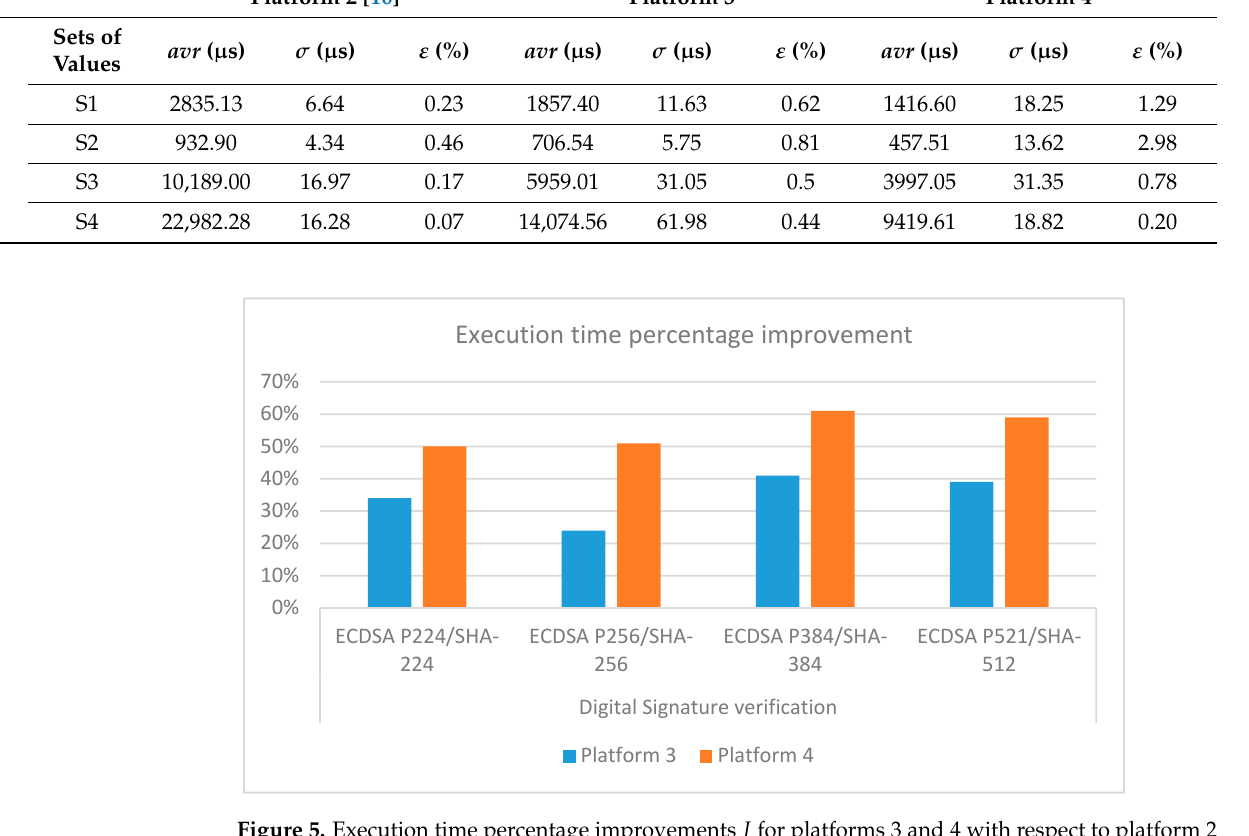
Table 7. Execution time profiling of the digital signature verification obtained on the three embedded platforms with the sets of values S1 to S4 in Table 3. © [2020] IEEE. Extended, with permission, from [16].